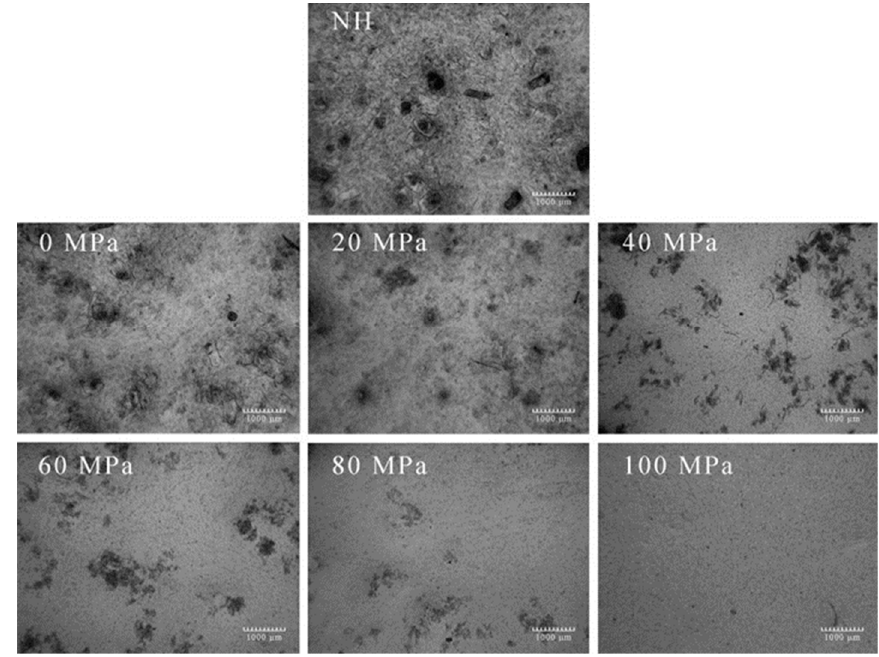
Figure 2. Effect of pressure of high-pressure homogenization on the microstructure of lily pulp. The scale bar shows 1000 μ m.